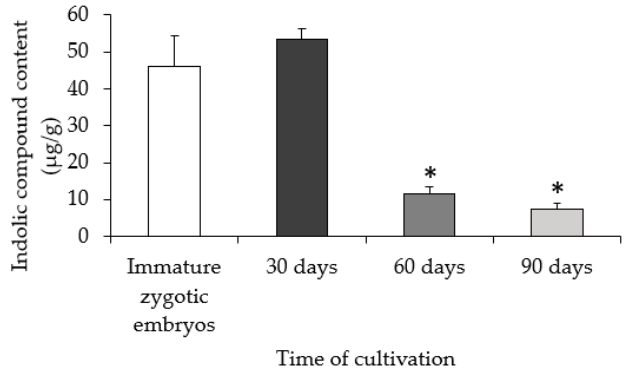
Figure 3. Indolic compounds content on the 30th, 60th, and 90th day of cultivation. The asterisks * indicate values that are significantly different from the immature zygotic embryo control (Student’s t -test, p < 0.05; n = 3 ± SD).